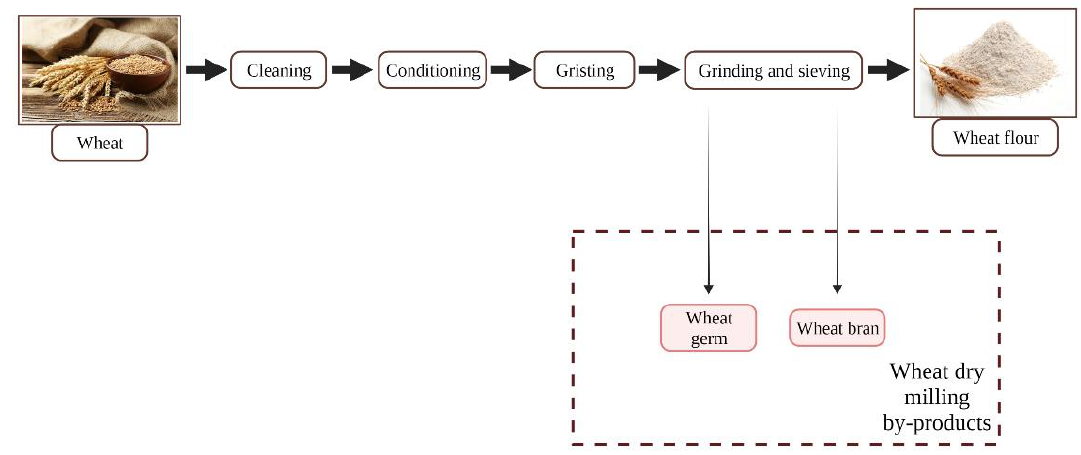
Figure 3. Types of by-products resulted after wheat processing